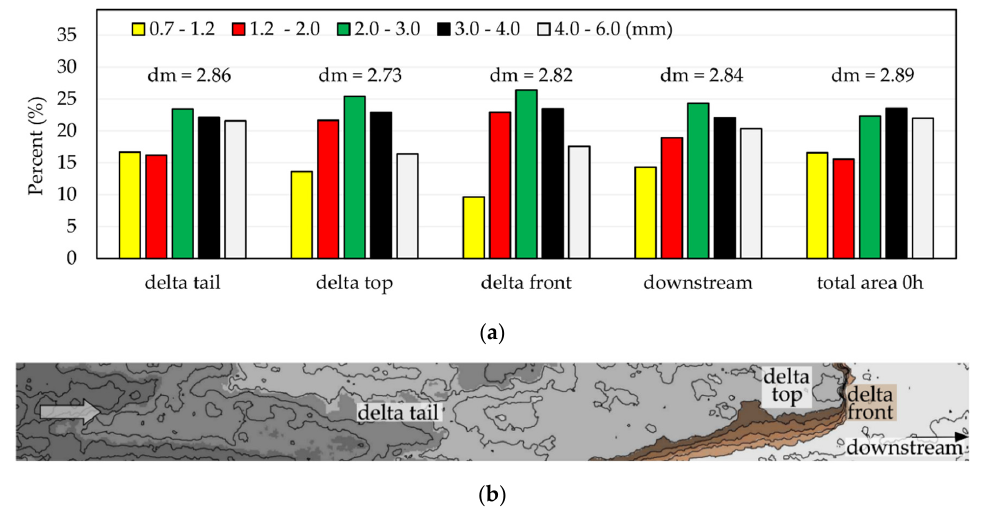
Figure 8. ( a ) Grain size distributions of the delta formation for test run D2 after four hours; ( b ) plan view of delta formation indicating the areas of delta tail, delta top, delta front and downstream section, respectively.